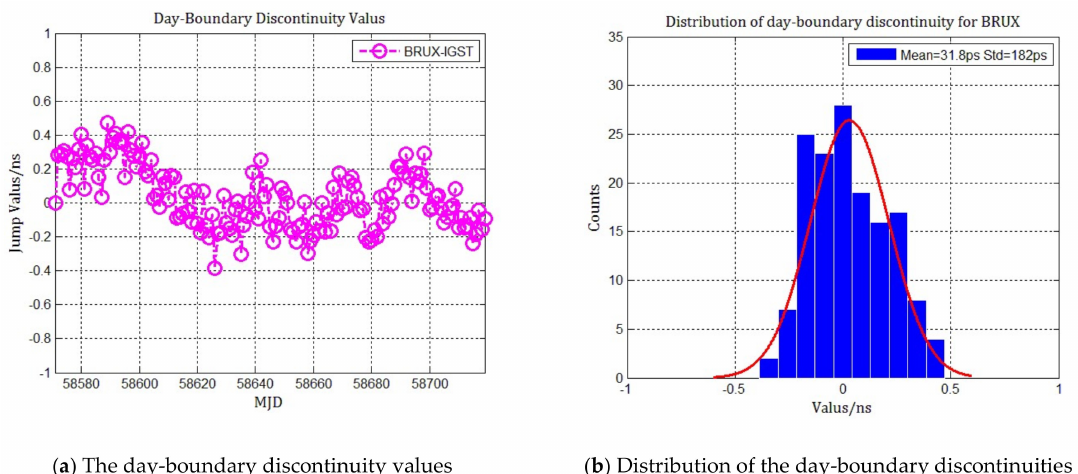
Figure 2. Statistics of the day-boundary discontinuities and distribution in combined multi-GNSS PPP for BRUX. ( a ) The day-boundary discontinuity values in nanoseconds; ( b ) The distribution of the day-boundary discontinuities compared to Gaussian